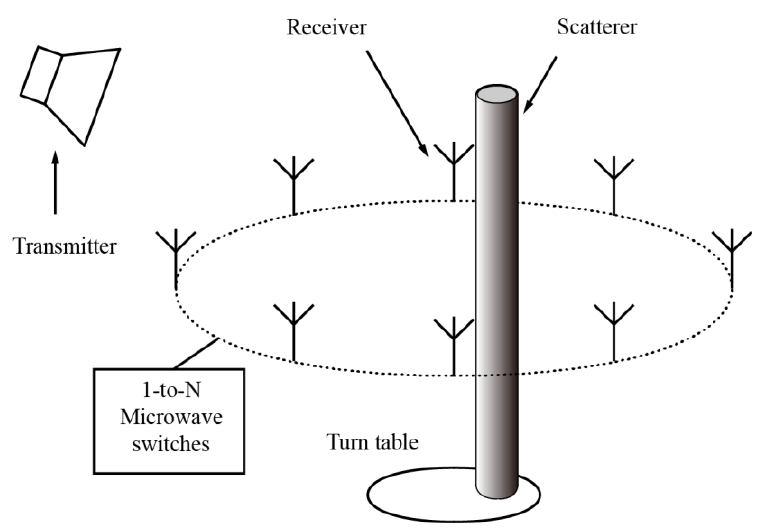
Figure 2. Proposed experimental setup with an oblique incidence and a 1-to-N microwave switching network.